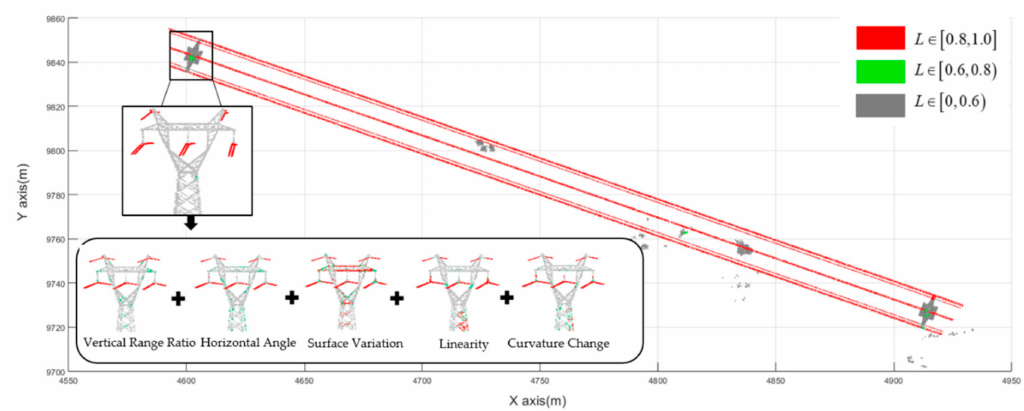
Figure 7. An example of the entropy-weighting feature evaluation. Different color represents different evaluation level. The grey represents the evaluation values under 0~0.6, the orange represents the evaluation values under 0.6~0.8 and the red represents the evaluation values under 0.8~1.